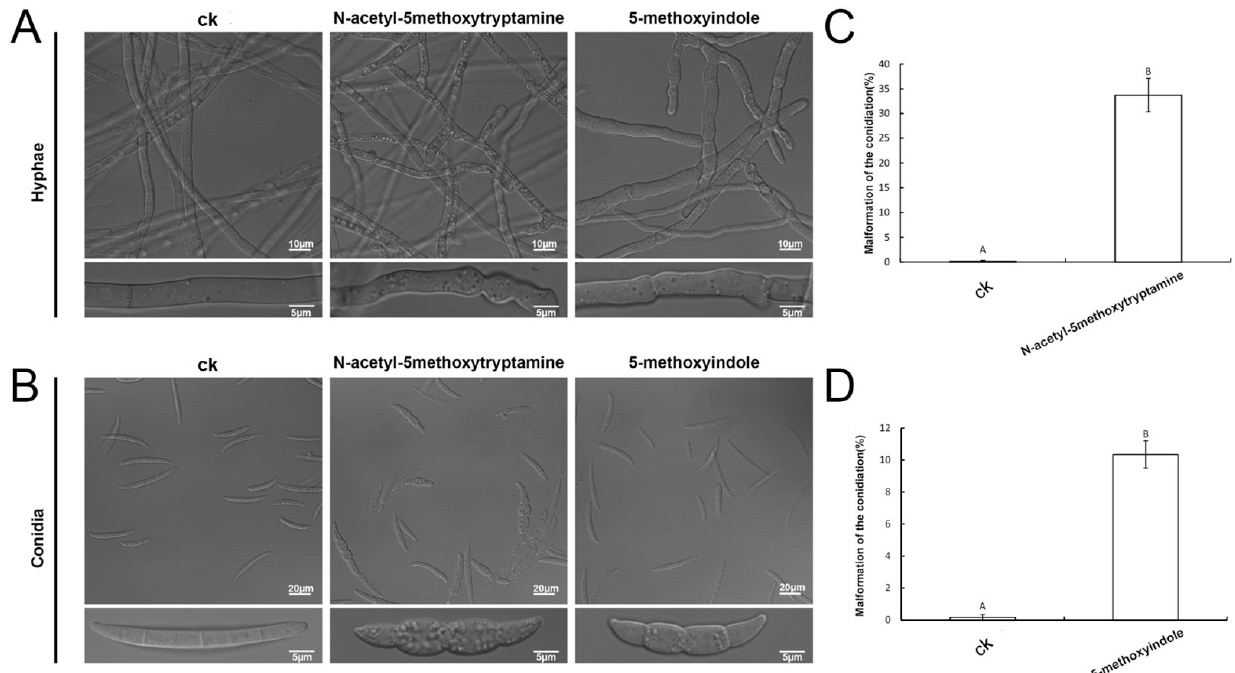
Figure 4. Effect of the melatonin and the 5-methoxyindole on the morphology of F. graminearum PH-1 hyphae and the conidia. ( A ) Effect of 4 mM melatonin and the 1 mM 5-methoxyindole on the morphology of F. graminearum hyphae observed with a microscope of the LSM 880 with Airyscan. ( B )The morphological changes of F. graminearum conidia treated with the 1 mM melatonin and the 0.1 mM 5-methoxyindole grown for 3 days. ( C , D ) The swollen rate of conidia after treatment with melatonin and 5-methoxyindole grown for 3 days. The experiment was repeated independently three times, and 0.05% (vol/vol) methanol/water served as the ck. The error bars represent the mean standard deviation of each treatment repeated three times with three replicates. The letters above the columns indicate significant differences. The significant difference between the treatments was determined through Tukey’s HSD test at p ≤ 0.05.